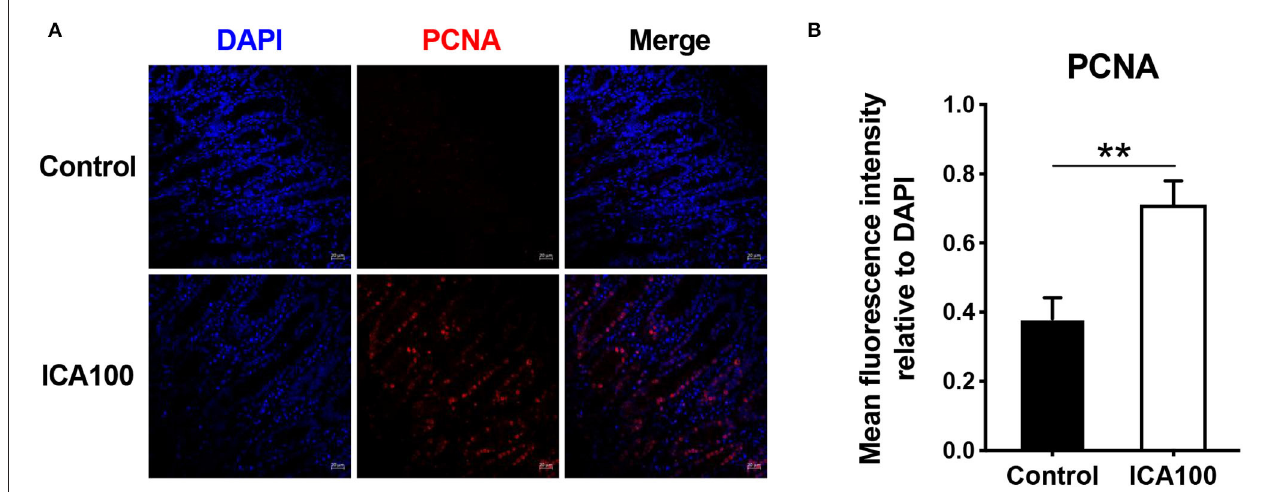
FIGURE 5 | ICA promotes the proliferation of intestinal epithelial cells in vivo . The jejuna were stained for PCNA (red), and the nuclei were stained with DAPI (blue). Data are expressed as mean ± SEM. ** P < 0.01 vs. the Control group. ICA100, the basal diet supplemented with 100 mg/kg indole-3-carboxaldehyde. PCNA, proliferating cell nuclear